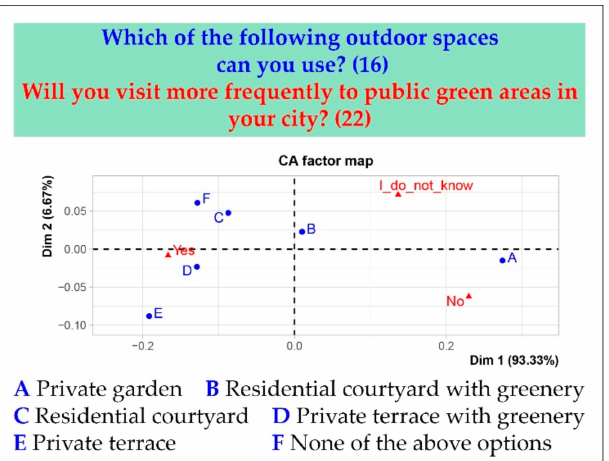
Figure 9. CA results for the relationship between the respondent outdoor space availability dur- ing the social distancing period and their potential use of public green areas after the period (questions